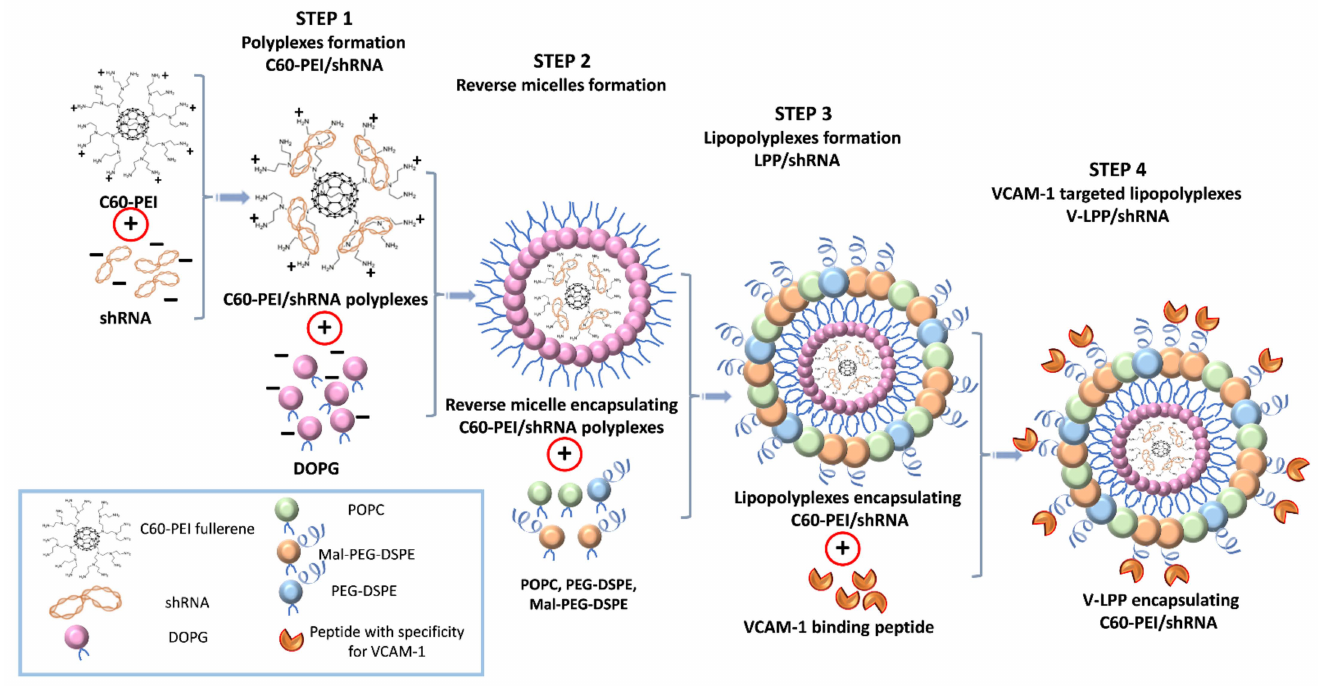
Figure 1. Schematic representation of the successive steps in the synthesis of VCAM-1 tar- geted lipopolyplexes encapsulating the shRNA plasmid lipopolyplexes (V-LPP/shRNA). First, the core-shell structures consisting of fullerene (C60) core and branched low molecular weight polyethyleneimine (PEI) (2kDa) were complexed with the plasmid containing shRNA sequences spe- cific for Runx2 (shRunx2) or scrambled sequences (shCTR). Second, the anionic phospholipid DOPG dissolved in chloroform/methanol was added to the positively charged C60-PEI/shRNA polyplexes to form reverse micelles entrapping the polyplexes and, third, the organic phase was removed by reverse-phase evaporation under reduced pressure in the presence of coating phospholipids